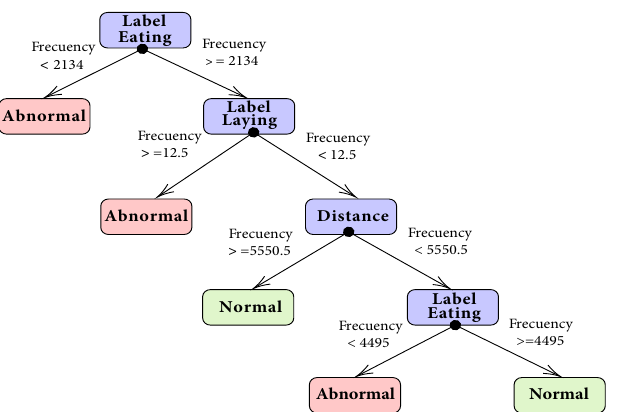
Figure 8. Decision tree generated.